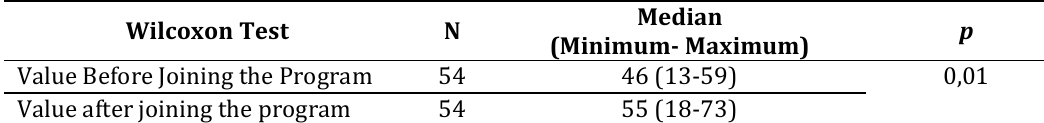
Results of the Wilcoxon Test